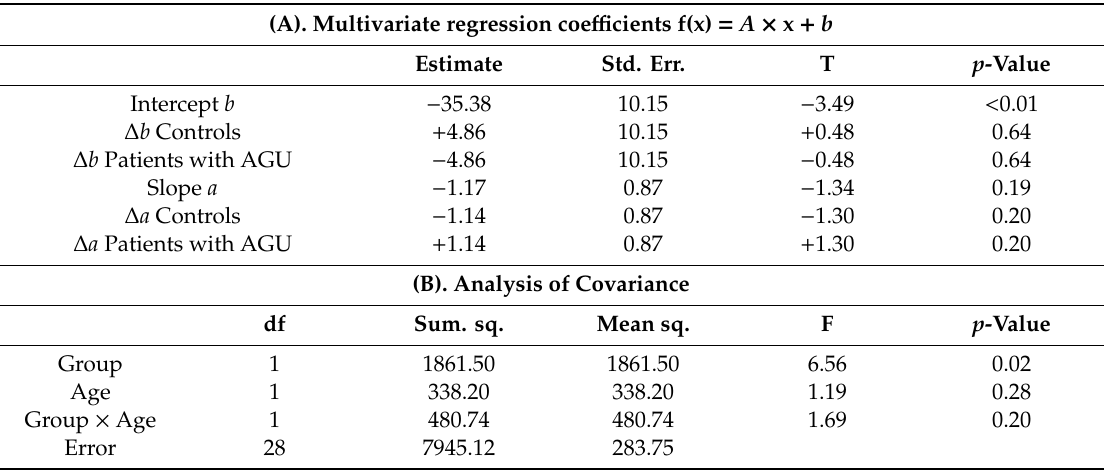
Table 1. The whole thalamus test results between age and average image